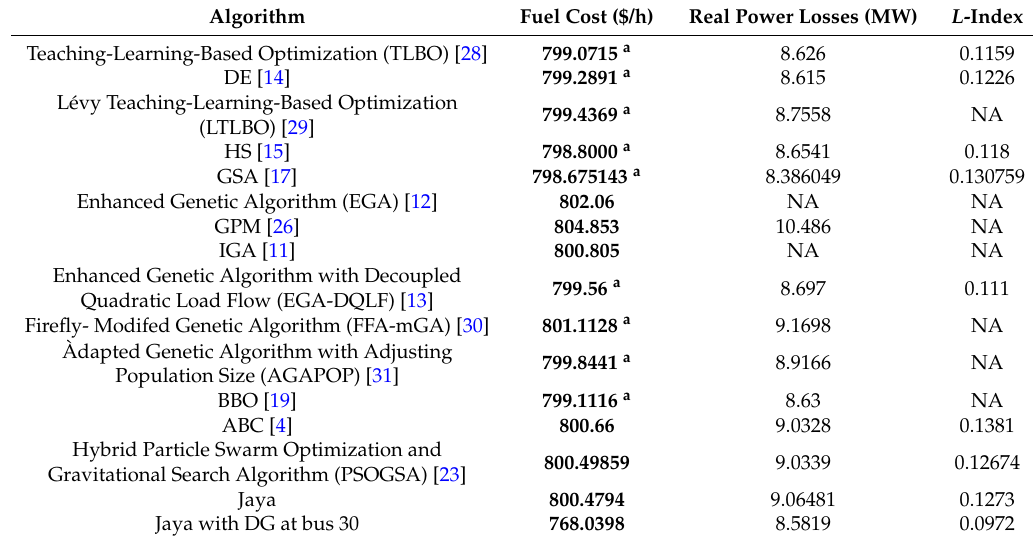
Table 2. Comparison of the solutions obtained for cost reduction (modified IEEE 30-bus network).